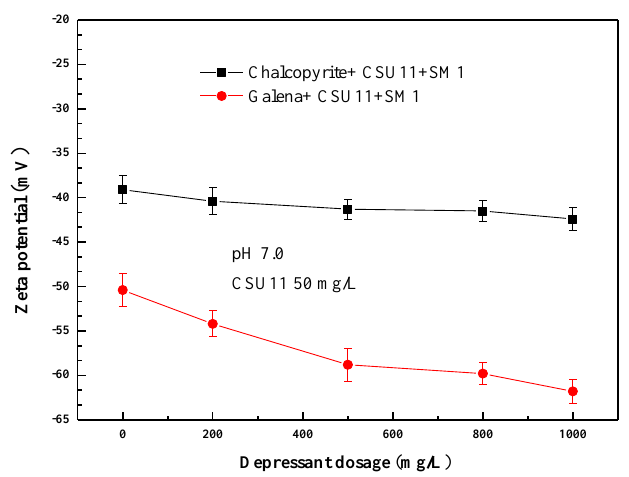
Figure 8. Effect of SM1 concentration on the zeta potentials of the mineral samples.